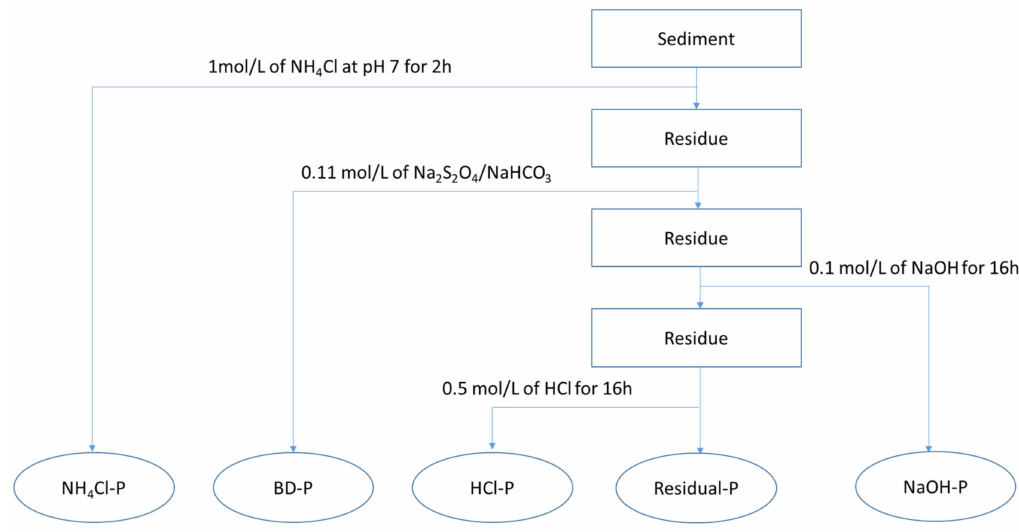
Figure 2. Sequential phosphorus (P) fractions